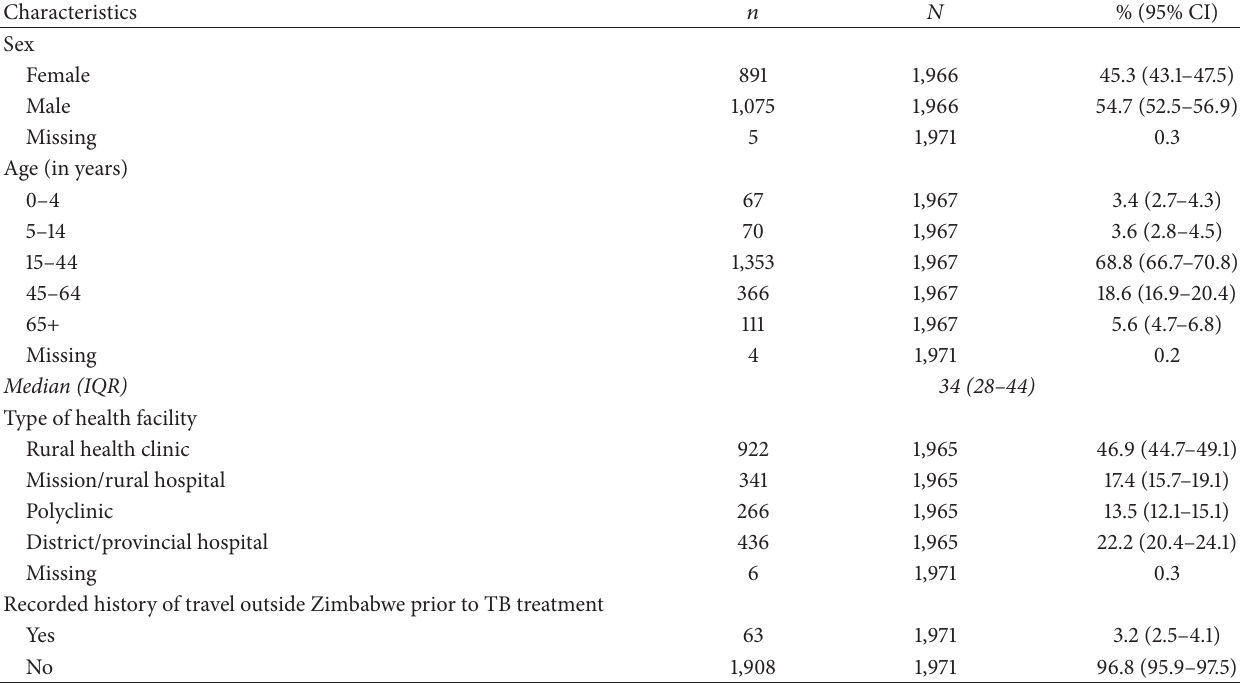
Table 1: Demographic characteristics of TB patients in southern Zimbabwe,